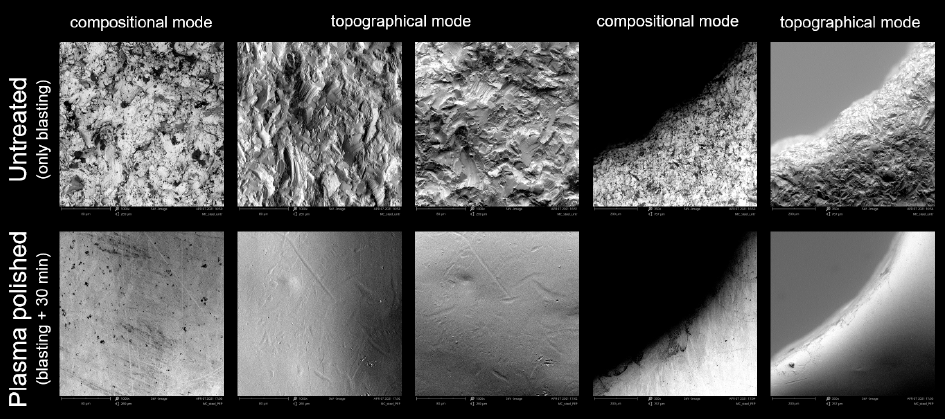
Figure 5. SEM images (1000 × ) of a 316L stainless steel specimen manufactured by selective laser melting, before and after plasma-electrolytic polishing for 30 min. Aside from the surface roughness reduction, the smoothening of edges is also noticeable. Phenom Pro Desktop SEM, Thermo Fisher, 5 kV acceleration